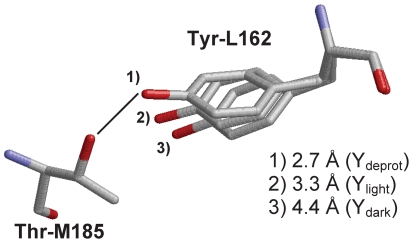
Variation of the Tyr-L162 side chain positions in the 1) Ydeprot, 2) Ylight, and 3) Ydark conformers.The OThr-M185–OTyr-L162 distances are 2.5 Å (Ydeprot), 3.3 Å (Ylight), and 4.4 Å (Ydark). Note that the OSer-M188–OTyr-L162 distances are 5.3 Å (Ydeprot), 5.7 Å (Ylight), and 6.8 Å (Ydark).